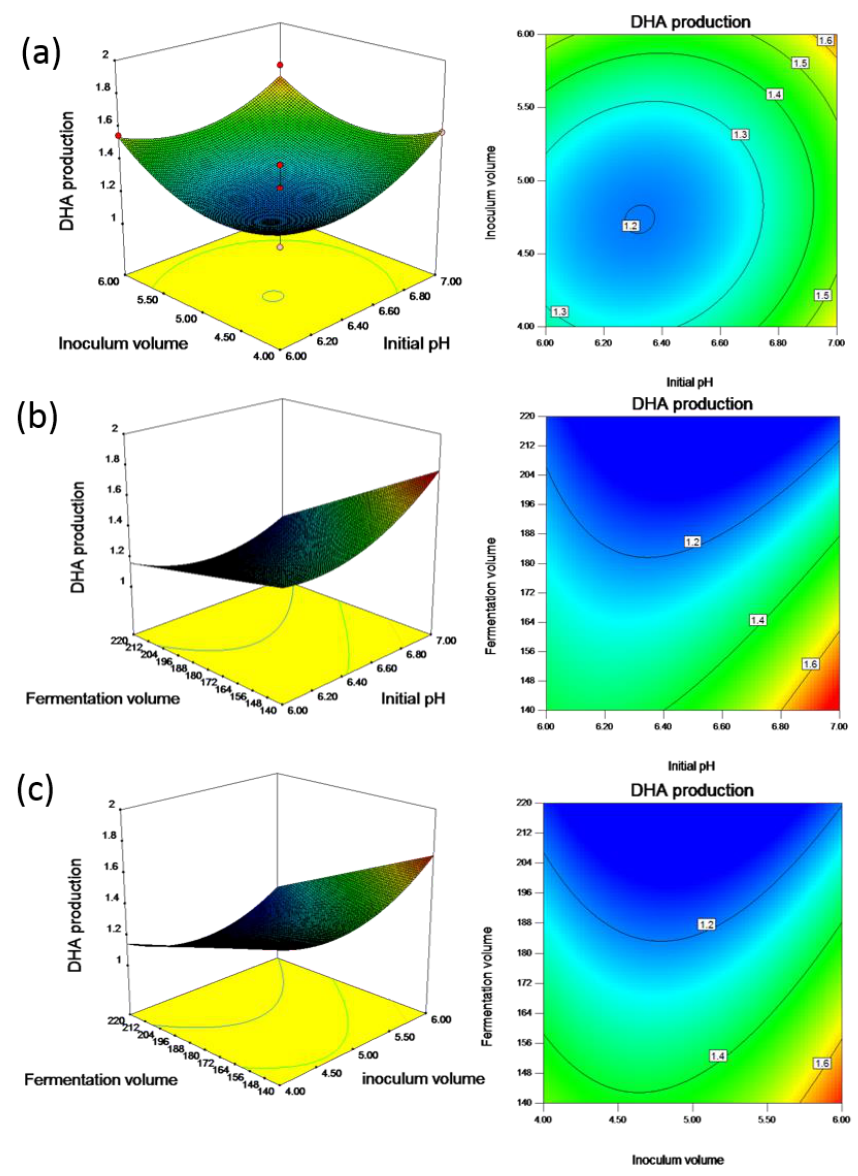
Figure 2. Response surfaces and corresponding contours of DHA production in terms of interaction between ( a ) inoculum volume (mL) and initial pH; ( b ) fermentation volume (mL) and initial pH; and ( c ) fermentation volume (mL) and inoculum volume (mL).